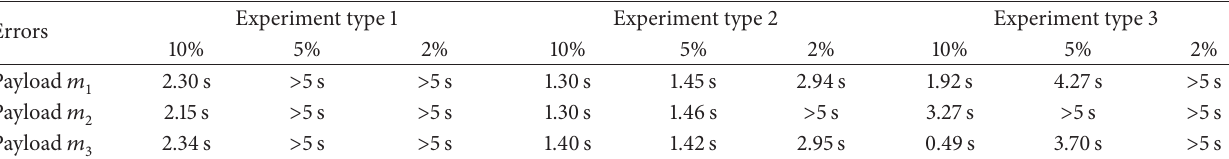
Table 4: Linear least squares fitting: convergence time for the different experiments and payloads.